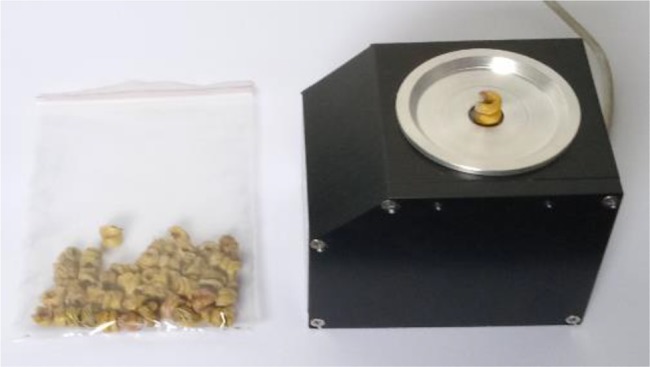
The sample presentation to record NIR spectra of fengdous.